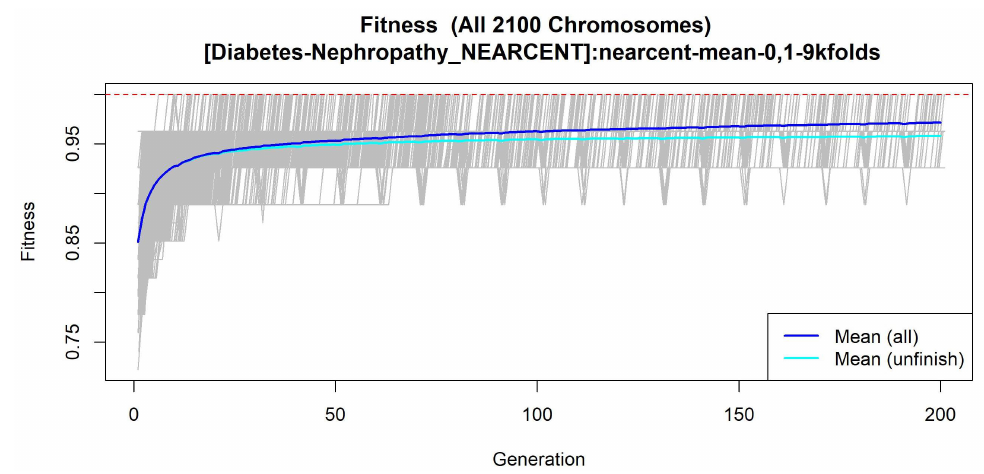
Figure 15. Gene frequency and gene rank stability in the models are ascertained by applying GA with NEARCENT to select the main features from the T2DM-DN dataset. ( A ) Gene frequency allows observing the number of times each feature appears in the models. ( B ) Gene rank allows observing the stability and frequency of each feature within the models and orders them by rank.